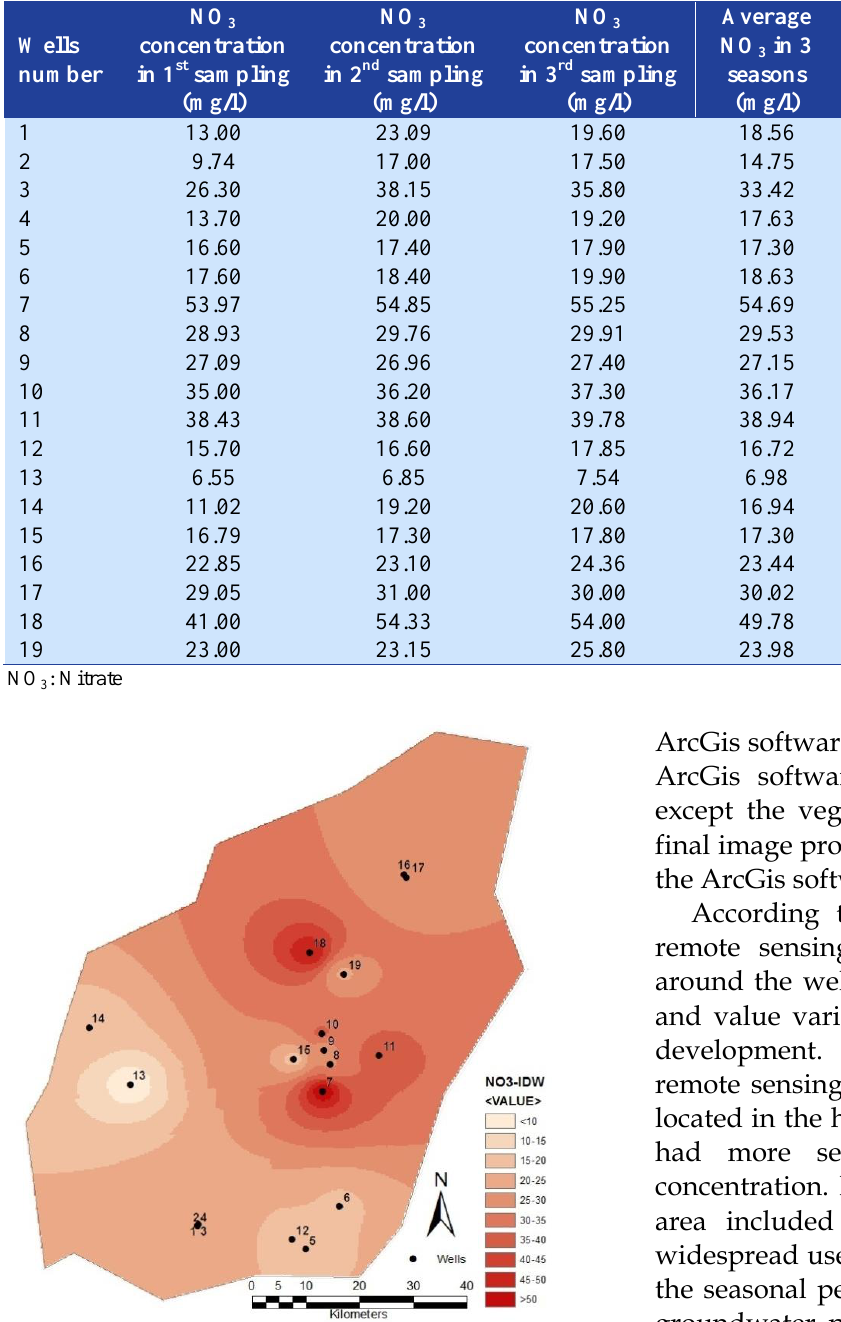
Table 1. The statistical description of nitrate in the wells of Birjand Wells